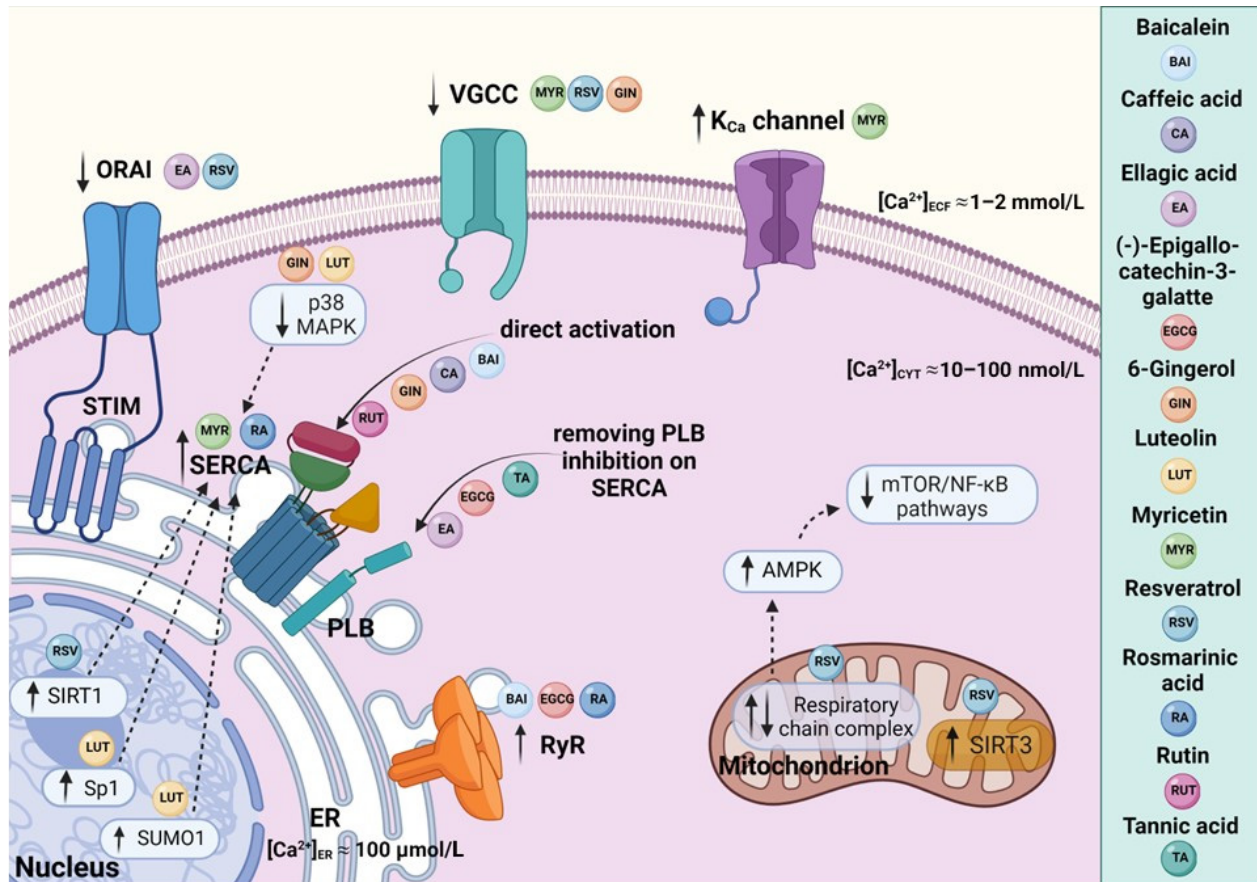
Figure 2. A schematic representation of polyphenol-mediated effects on SERCA and related intracellular Ca 2+ signaling pathways: Dietary polyphenols affect Ca 2+ dynamics by targeting Ca 2+ transporters and channels as well as downstream processes. Baicalein, rutin, caffeic acid, and gingerol seem to stimulate SERCA directly. On the other hand, ellagic acid, (-)-epigallocatechin-3-gallate, and tannins were described as indirect SERCA activators acting by relieving the inhibition of SERCA by PLB. Resveratrol has been shown to interact with several Ca 2+ -handling proteins, and to modulate Ca 2+ homeostasis through intervention in Ca 2+ signaling pathways. In particular, the activation of deacetylase SIRT1 has been reported as a central mechanism of resveratrol action responsible for upregulation of SERCA. The release of Ca 2+ from the ER via RyRs was shown to be facilitated by baicalein, (-)-epigallocatechin-3-gallate, and rosmarinic acid. Luteolin, myricetin, and rosmarinic acid increase the overexpression of SERCA. The regulatory effects of myricetin, resveratrol, gingerol, and ellagic acid were described in relation to Ca 2+ -dependent channels, such as VGCCs, ORAI–STIM, and the K Ca channel. Figure created with BioRender.com.